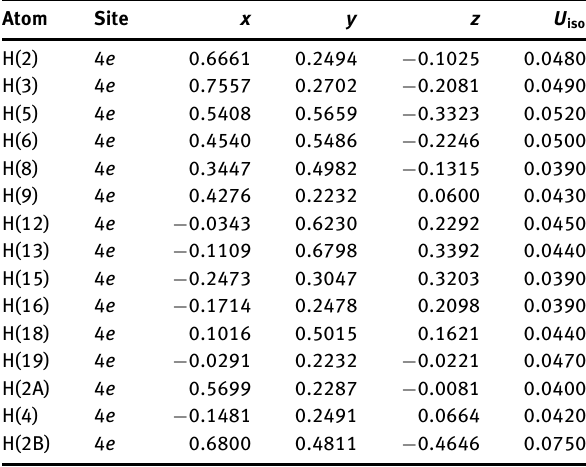
Table 2: Fractional atomic coordinates and isotropic or equivalent isotropic displacement parameters (Å 2